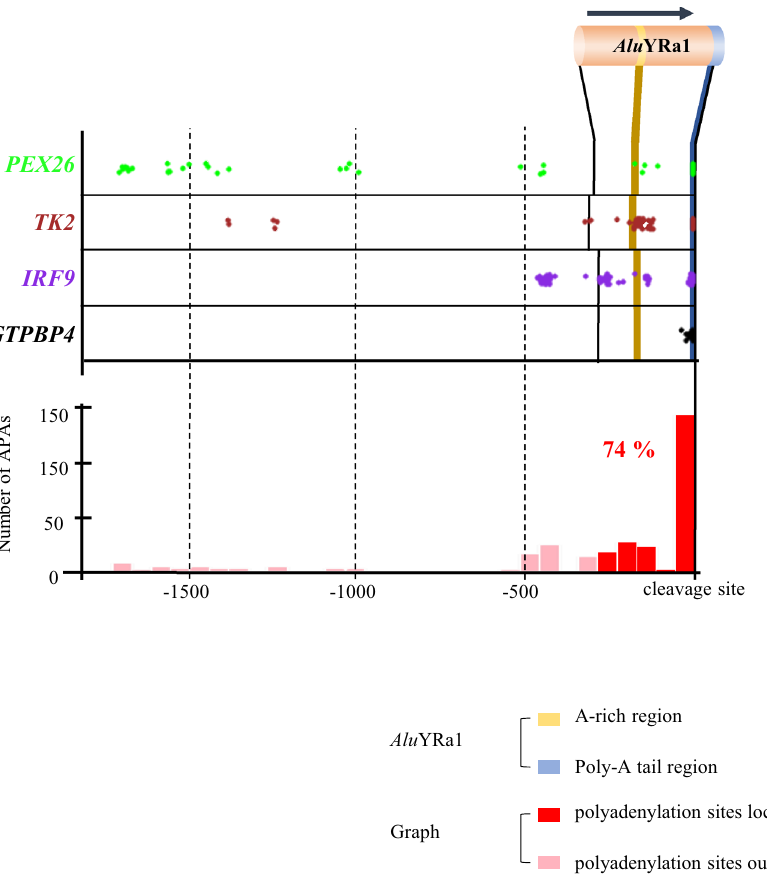
Figure 7. TAPAS analysis. The TAPAS software run on 30 cynomolgus macaques resulted in a certain output file, and we statistically analyzed this output file. Dots represent APA sites. Pink bar indicates the accumulation of the dots (APA sites) above, and the red bar represents the same, but the total red bars represent the total APA sites that are located on the Alu YRa1 sequence. The total ratio is 74%. APA; alternative